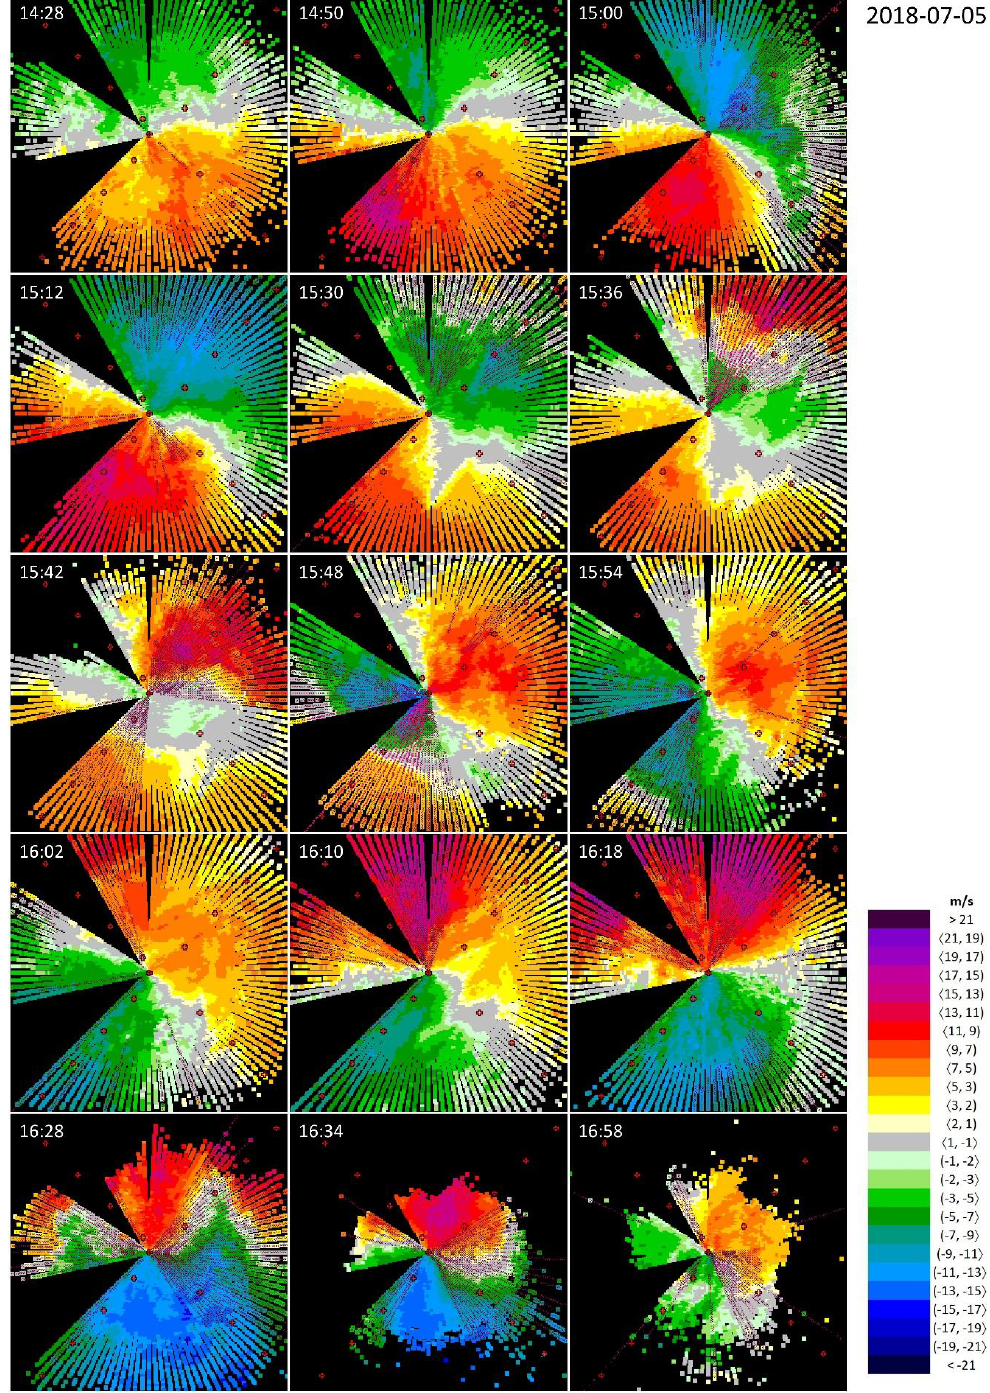
Figure 8. Wind shear at the passage of a cold front from 14:28 UTC until ~17:00 UTC on 5 July 2018, seen by the lidar at the Bratislava Airport, located at the center of each figure. Wind blowing towards the lidar is defined as positive. The empty (full) pink circles indicate wind shear condition (microburst condition), according to the ICAO thresholds.